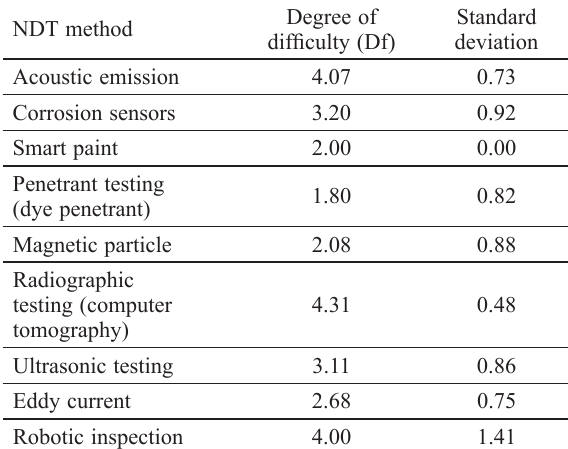
Table 8. Steel NDT methods: degree of